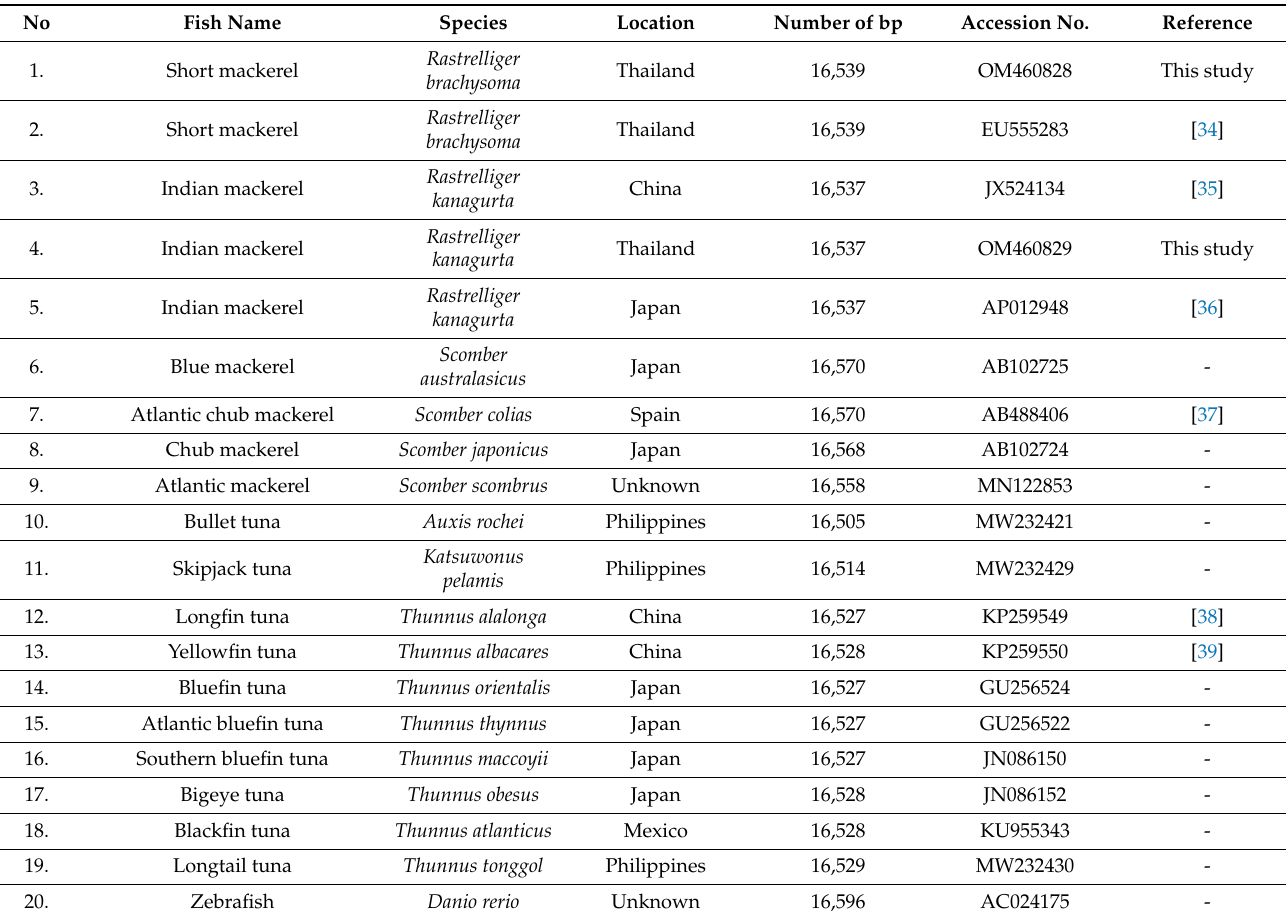
Table 5. mtDNA sequences used in phylogenetic